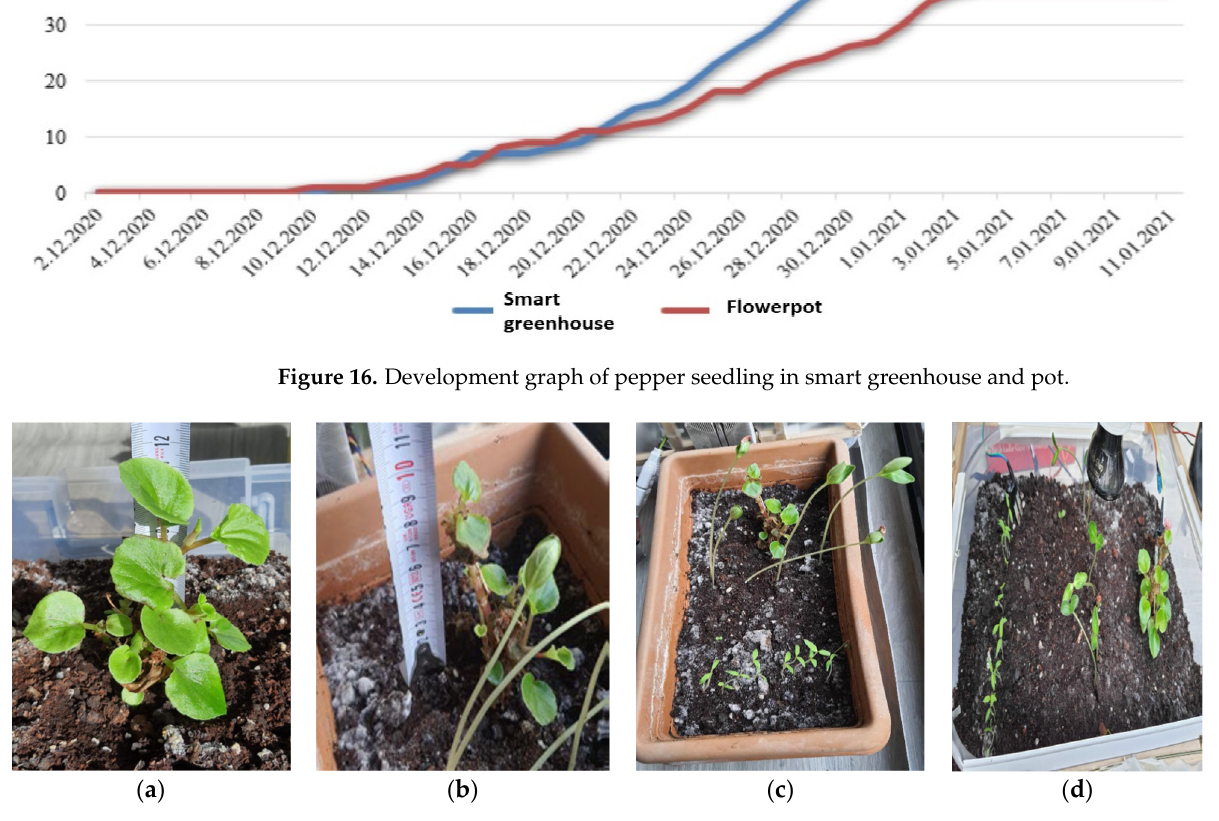
Figure 17. Final status of the begonia flower ( a ) in the smart greenhouse ( b ) in the pot and the sun-related changes of plants ( c ) in the pot and ( d ) in the smart greenhouse.